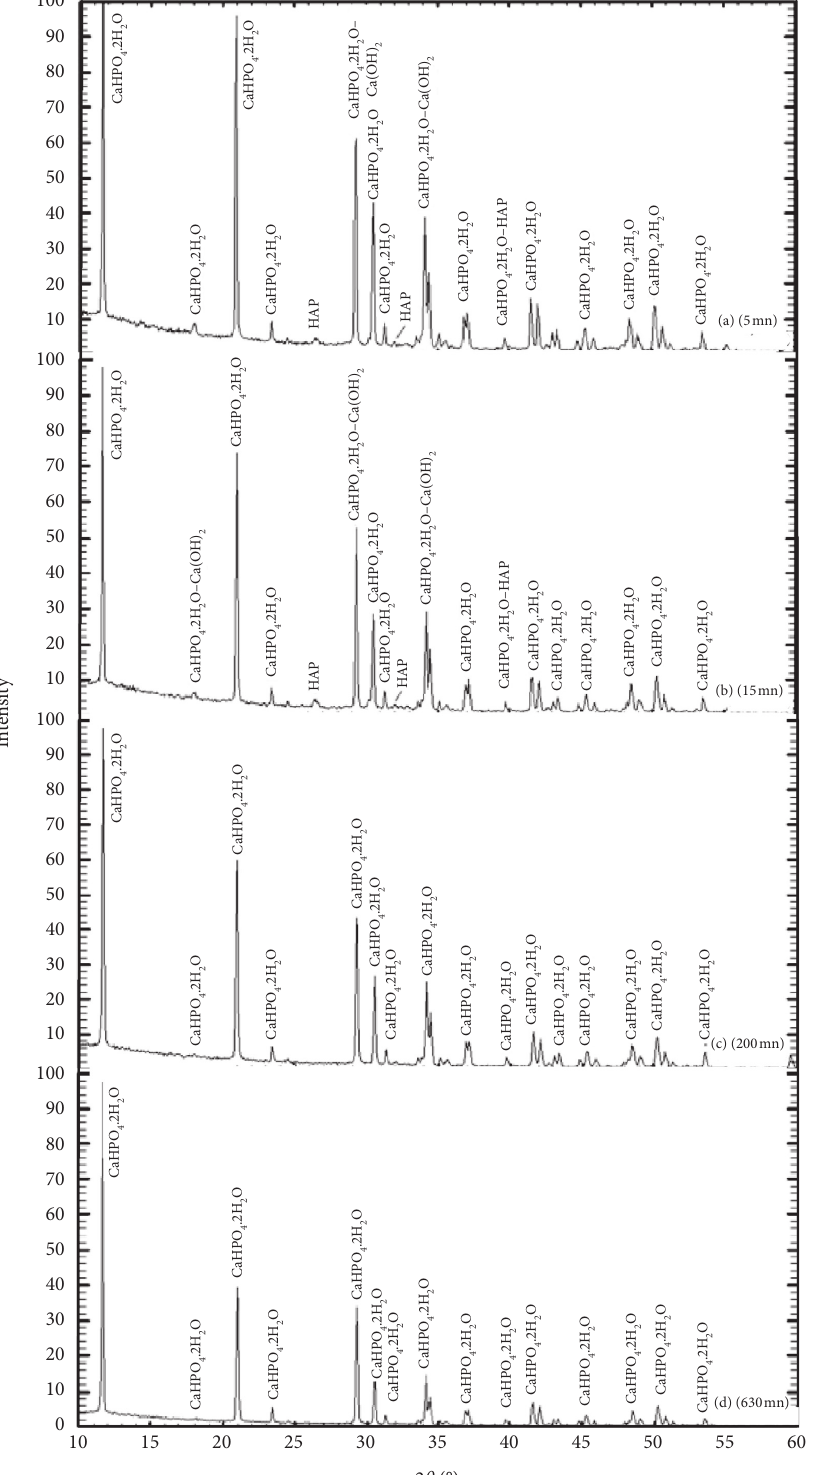
Figure 7: X-ray diagrams of the solid phase taken from mixture M 3 as a function of time: (a) at 5min, (b) at 15min, (c) at 200min, and (d) at